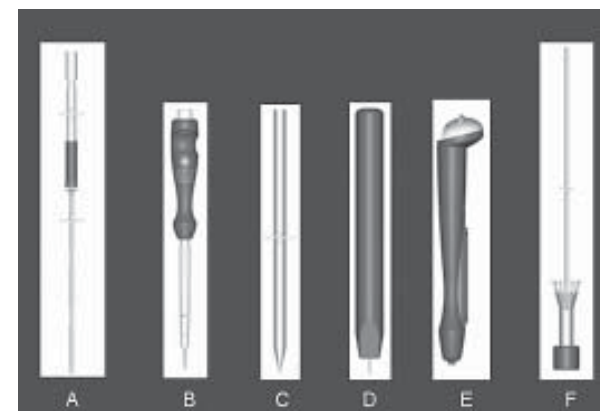
Fig. 1 – Design of the different components of the mechanical suture device. A – aortic connector loaded on the liberation system;